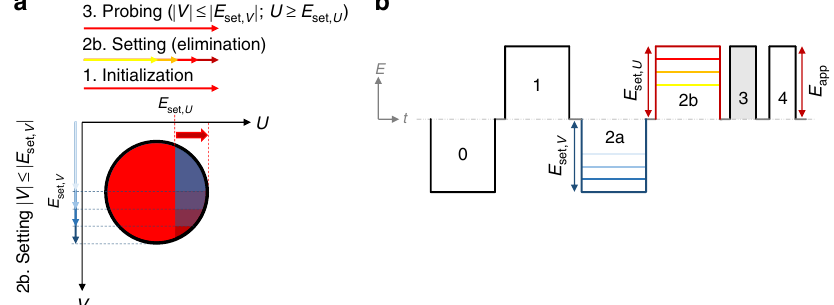
Fig. 5 Probing the switching kinetics of different parts of the Preisach distribution. a Schematics of the measurement in the Preisach plane. b The corresponding pulse sequence. Red indicates positive and blue negative poling. The red thick arrow indicates the measured PD projection on the U axis. Steps 0 and 1 reset the polarization state, the setting fi eld E set ,V and E set ,U in step 2 are gradually changed to probe the whole Preisach distribution. The switching kinetics is measured in step 3 at the applied fi eld E app (amplitude unchanged), while step 4 is used for non-switching background current evaluation. The pulse duration of all steps is kept